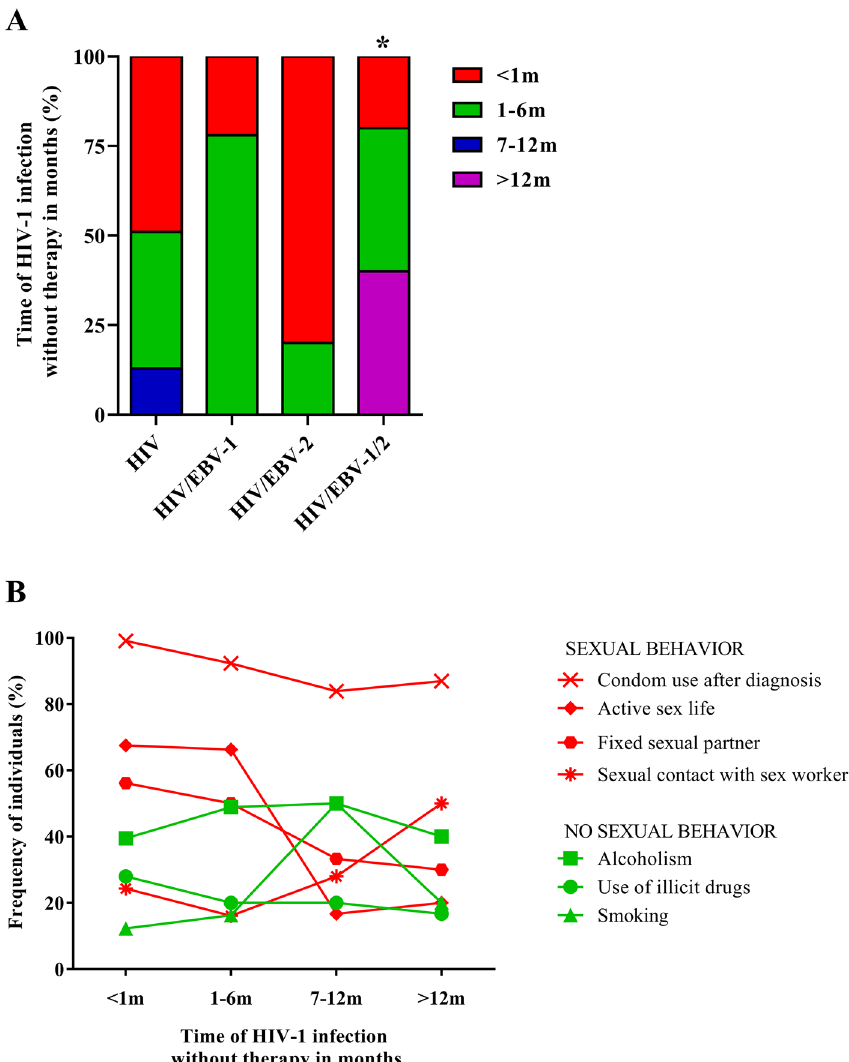
Figure 2. Late initiation of treatment for HIV-1 infection: ( A ) Frequency for initiation of HIV-1 infection treatment and monitoring, in months, after the primary diagnosis. Patients with multiple infection (HIV/ EBV-1/2) initiated treatment later. *p<0.05. ( B ) Evaluation of behavioral profiles at different initiation times for HIV-1 infection treatment and monitoring. Condom use after diagnosis was the most frequent behavior at all treatment initiation